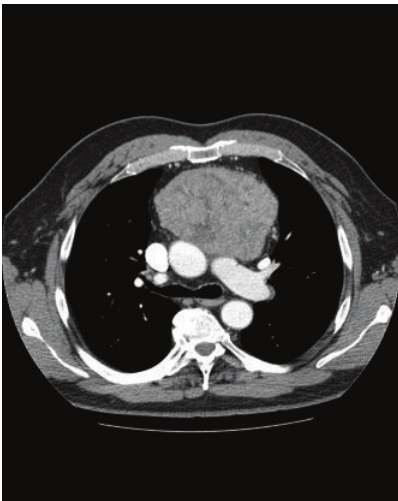
Figure 1: CT scan of the chest revealing a large heterogenous mass in the anterior mediastinum.